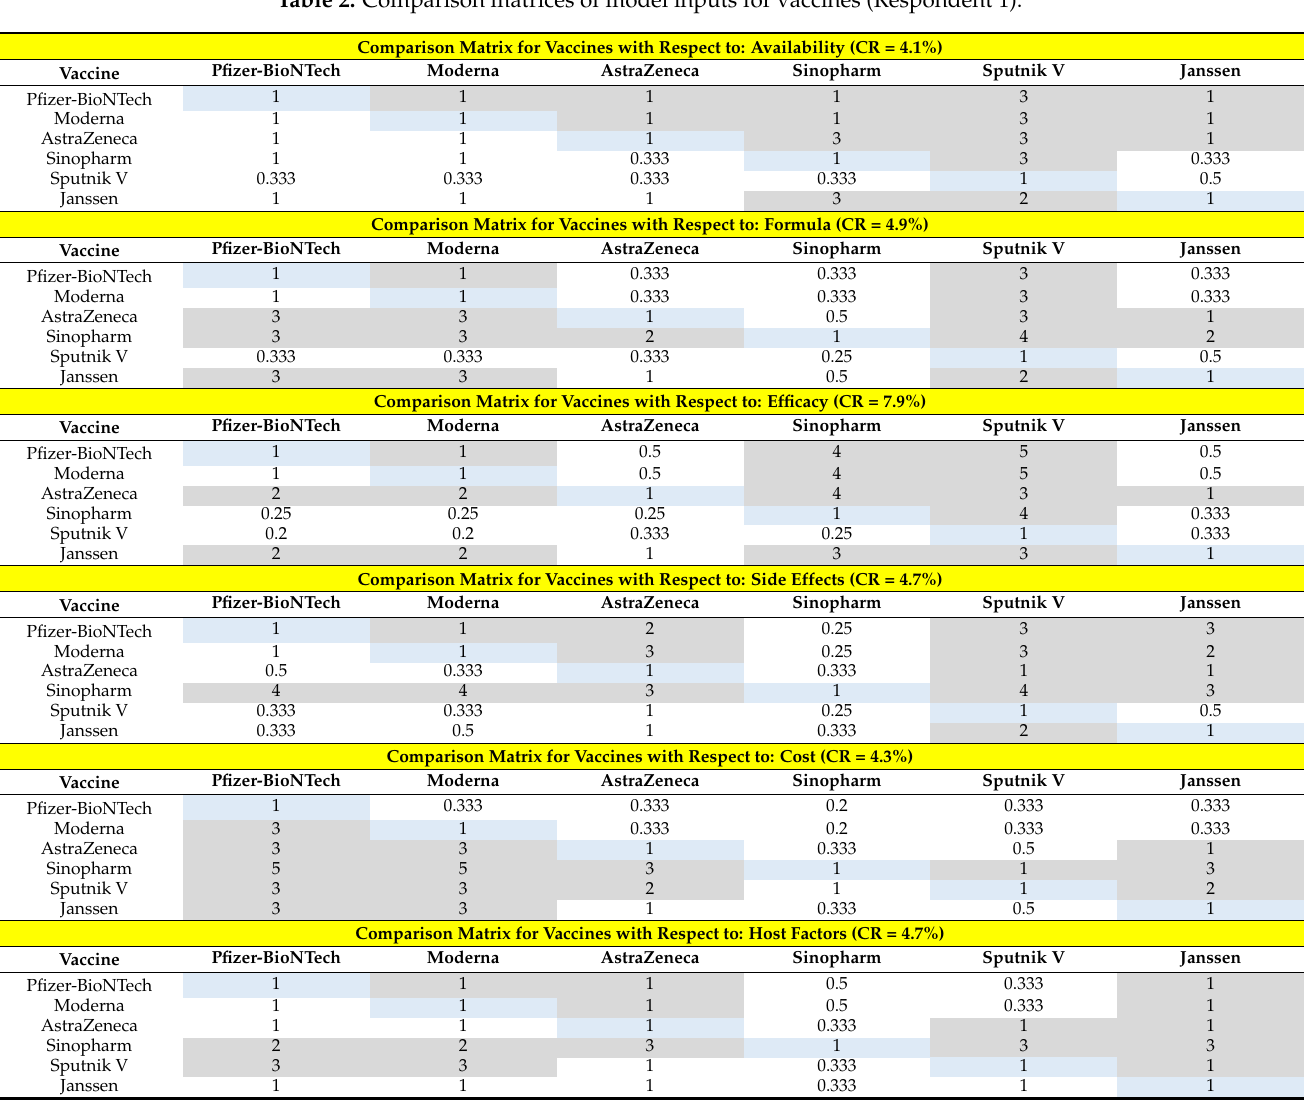
Table 2. Comparison matrices of model inputs for vaccines (Respondent 1). Comparison Matrix for Vaccines with Respect to: Availability (CR = 4.1%)